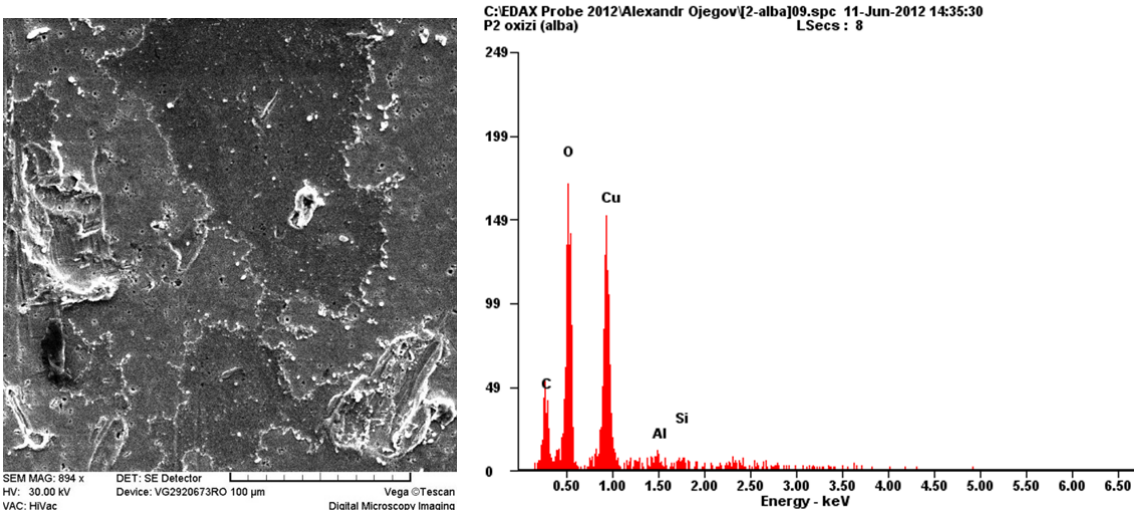
Figure 6 . SEM and EDX analysis brass Cu63Zn37 sample surface